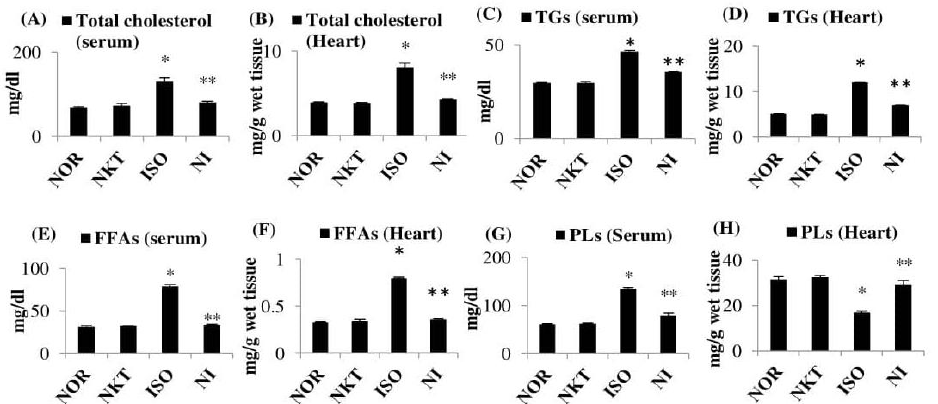
Figure 5. Effect of NKT on the levels of lipids/concentrations of lipids: ( A – H ) levels/concentrations of total cholesterol, triglycerides (TGs), free fatty acids (FFAs), and phospholipids (PLs) in the serum and heart. Each column is the mean ± SEM for eight rats in each group; * p < 0.05 as compared to the normal control (Group-I), ** p < 0.05 as compared to the ISO control (Group-III) (DMRT).